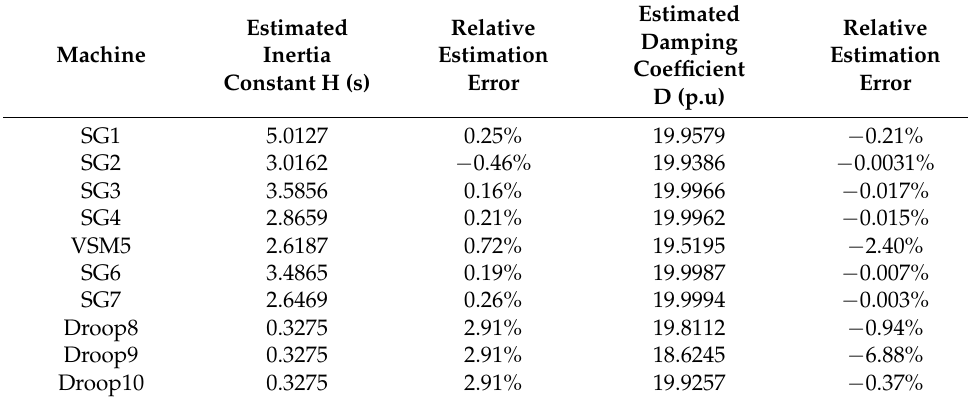
Table 2. Estimated inertia and damping at the machine level.